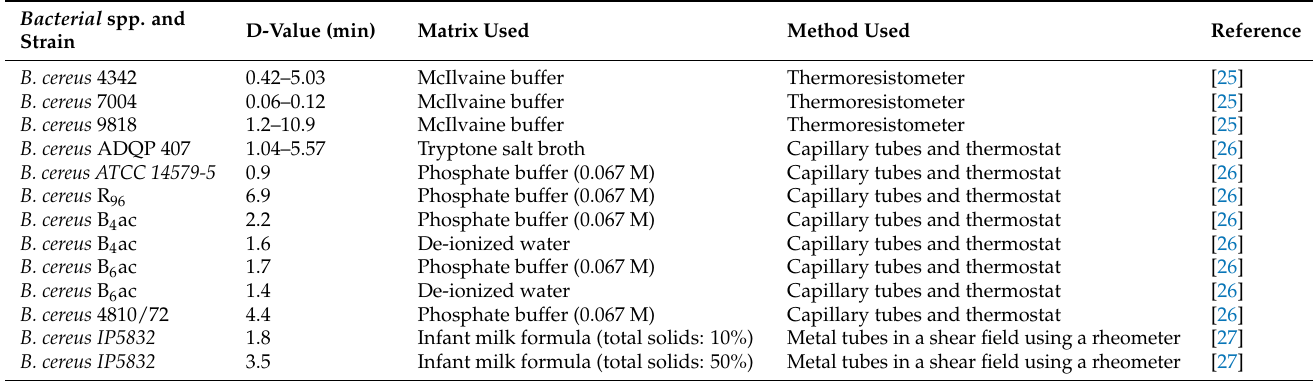
Table 1. Summary of D 100 -values (thermal resistance) for B. cereus spores along with the medium and the method used.